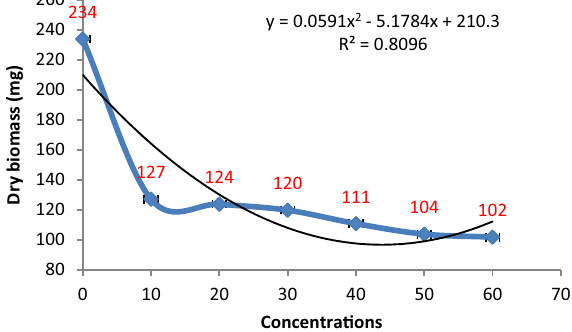
Figure 4. Effect of different metabolite concentrations of P. digitatum on the biomass production of P. herbarum. Vertical bars show standard errors of the means of three replicates.